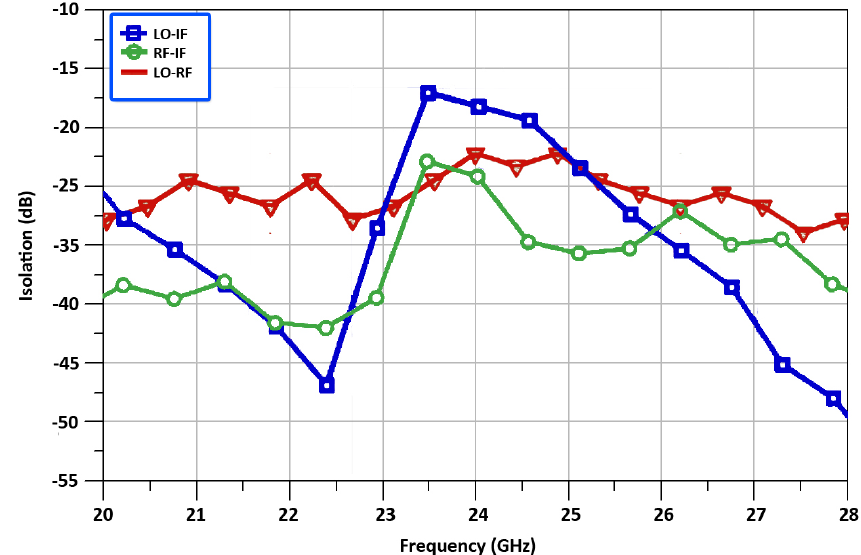
Figure 12. Isolations between the mixer’s